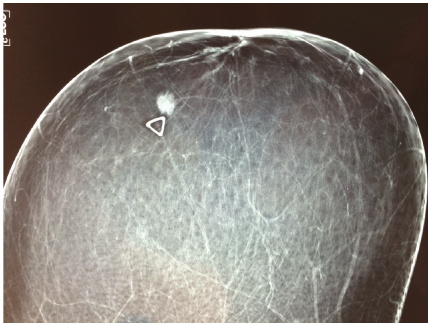
Figure 1: Left craniocaudal (CC) mammographic view: round centimetric mass with indistinct margin (arrow); BI-RADS 4.